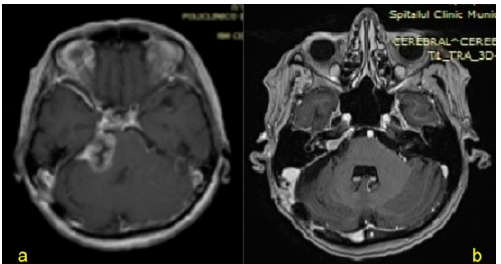
Figure 1. Right vestibular schwannoma, 1st patient, preoperatory ( a ), and prior to nastomosis ( b ).